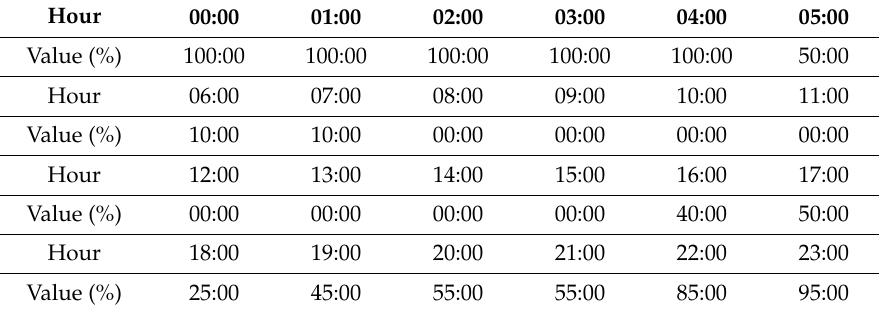
Table 2. Hourly schedule of the occupants / user’s (%) in the